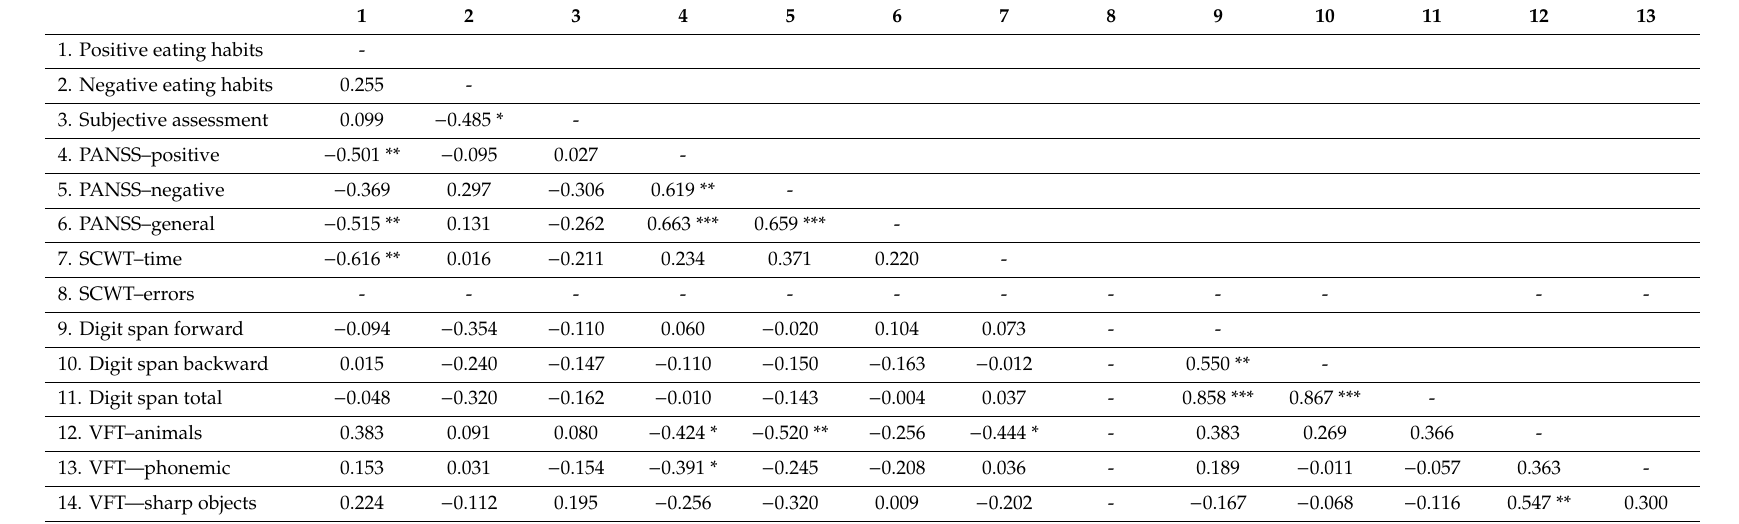
Table 5. Variable correlations in schizophrenia patients without MS ( N =